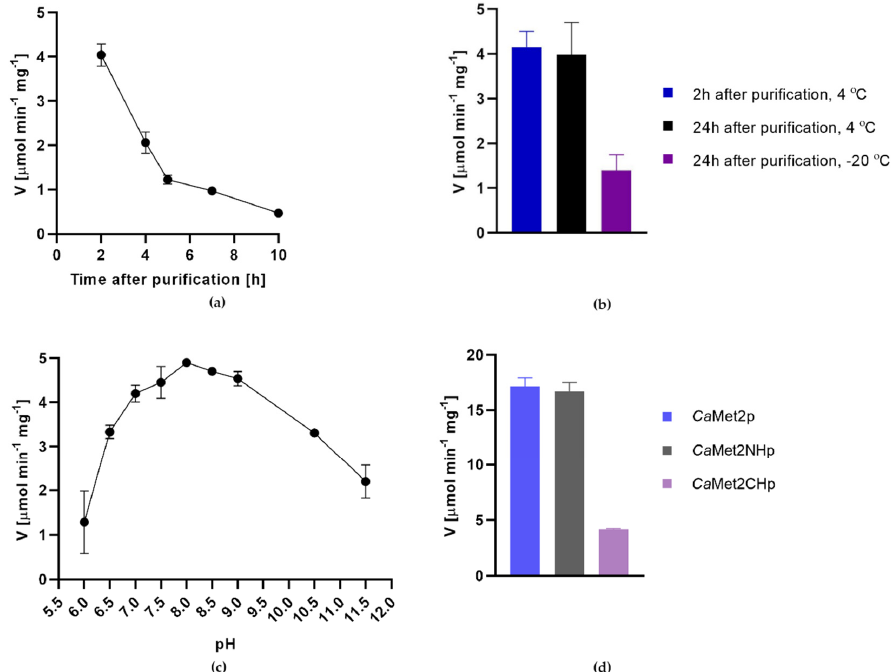
Figure 4. Determination of the optimum conditions for Ca Met2p/ Ca Met2NHp activity: ( a ) Loss of Ca Met2NHp activity in time when not supplemented with glycerol; ( b ) effect of glycerol addition as well as storage temperature on Ca Met2NHp stability; ( c ) dependence of Ca Met2NHp activity on pH; ( d ) comparison of Ca Met2p, Ca Met2NHp, and Ca Met2CHp activities measured at optimal conditions. Data are presented as means of at least three independent experiments (V [µmol·min − 1 ·mg − 1 ] ± SD). The kinetic parameters of Met2p from C. albicans determined for purified Ca Met2p and Ca Met2NHp versions are presented in Table 1. The respective parameters determined for both versions are similar, and in the case of the k cat values, almost identical. This indi- cates that catalytic properties of Met2p are not affected by the presence of the N-terminal oligoHis tag. On the other hand, the K M values appeared to be quite ambiguous compared to the ones determined previously by other authors for S. cerevisiae and S. pombe Met2p. They equaled 1.00 mM and 1.09 mM for L-Hom, and 0.0270 mM and 0.0209 mM for Ac- CoA, respectively. Especially the latter are very different from those determined by us for Ca Met2p. However, the S. pombe Met2p k cat values were equal to 9.6 s − 1 and 9.3 s − 1 for L- Hom and AcCoA, respectively, and they were comparable to the k cat of the C. albicans - derived enzyme. Although C. albicans, S. cerevisiae , and S. pombe belong to the same family, the parameters of the same enzyme can still differ between species. Interestingly, the K M values established for Met2p from Mycobacterium smegmatis that are equal to 0.06 mM for L-Hom and 0.158 mM for AcCoA [28] are closer to the values obtained by us for Ca Met2p. Table 1. Kinetic parameters of C. albicans Met2p and Met2NHp. Value of k cat were calculated per monomer. Data shown are the means of at least three independent experiments ± SD. Substrate K M [mM] k cat [s − 1 ]